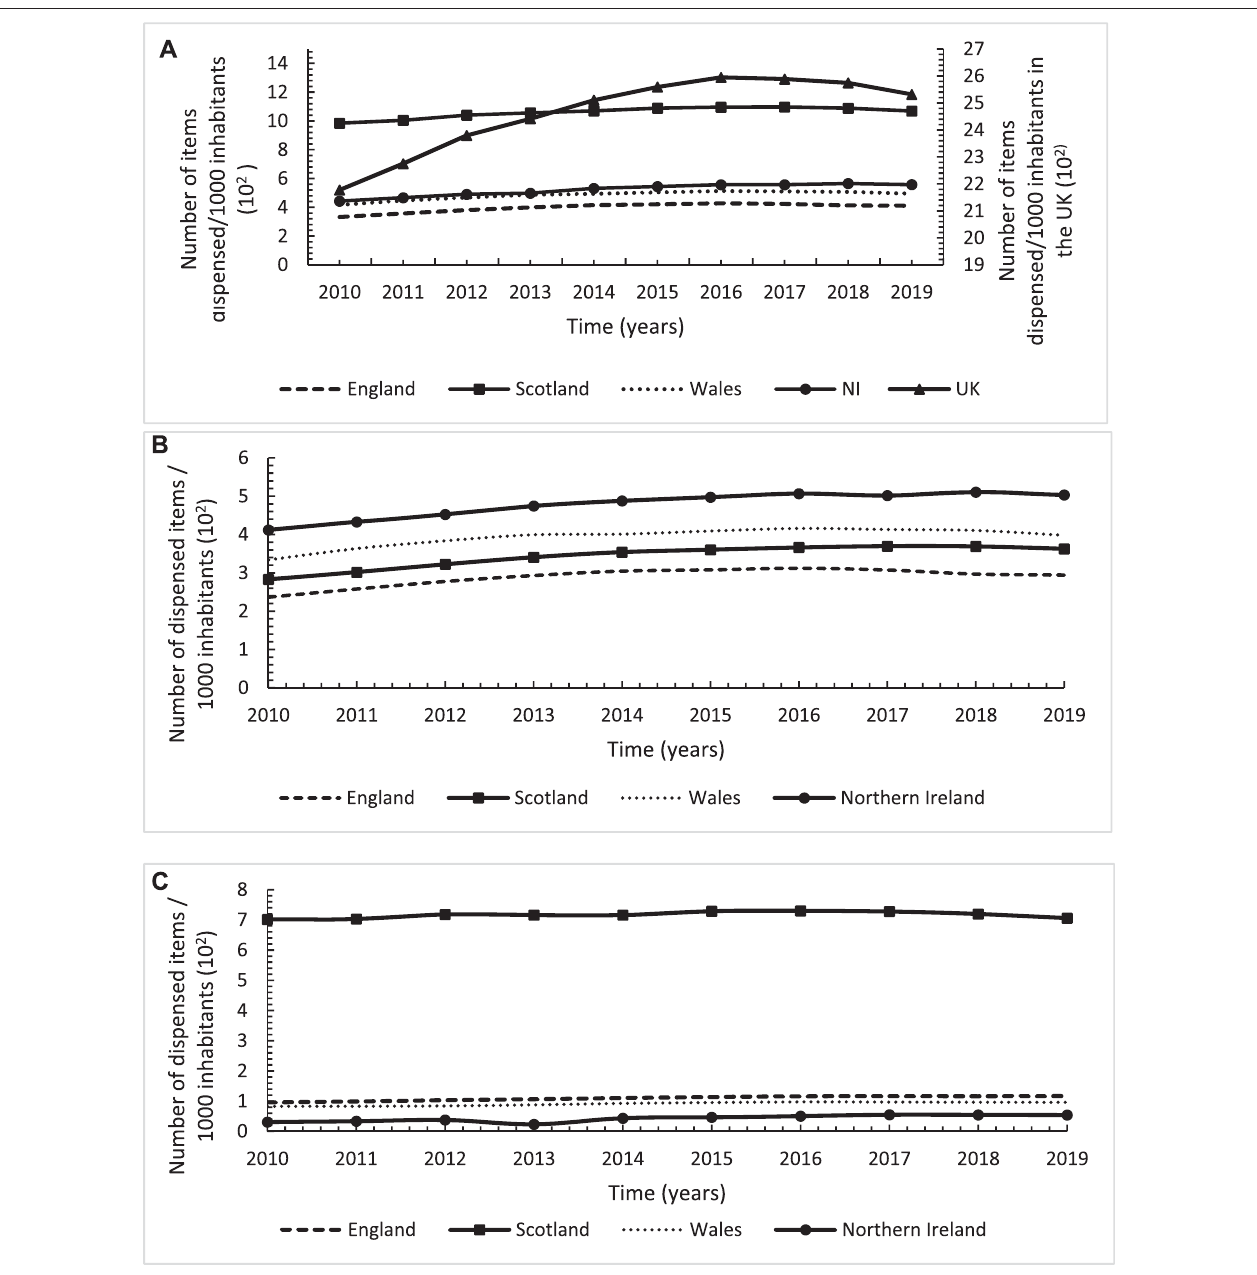
FIGURE 1 | Annual utilisation trends in number of dispensed items/1,000 inhabitants for opioids across England, Scotland, Wales and Northern Ireland over the study period from 2010 to 2019; (A) : Total opioids; (B) : Strong opioids; (C) : Weak opioids.